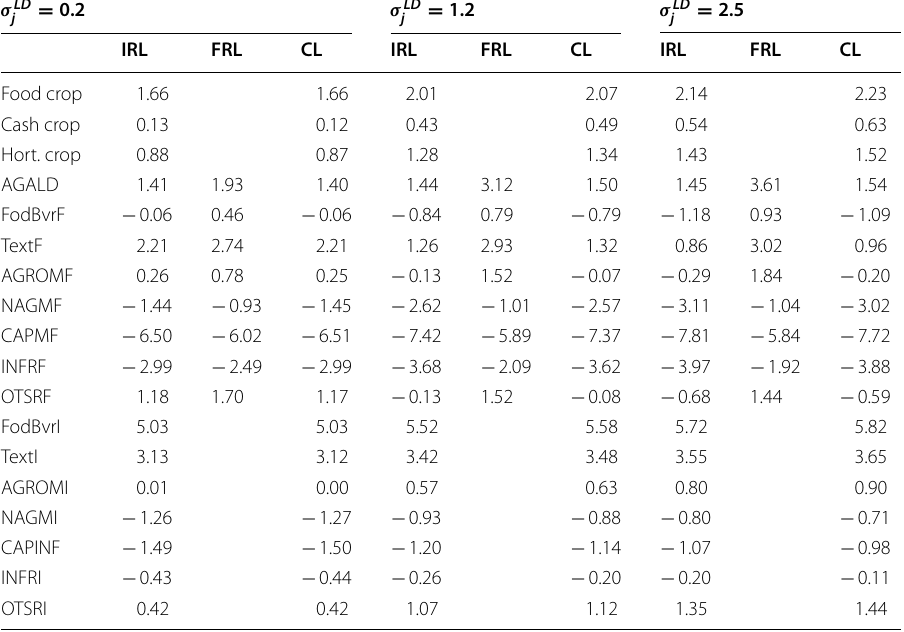
0.00 implies marginal increase